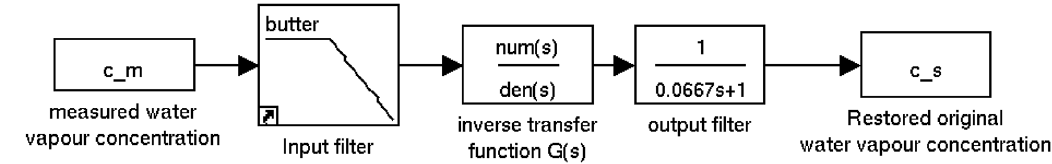
Figure 7. Block diagram of signal restoration. The input signal of the humidity sensor is filtered with a Butterworth filter of order 20 at a cutoff frequency of 10Hz. After the inverse transformation, the signal is filtered again with a simple first-order delay low pass with cutoff frequency at 15Hz.